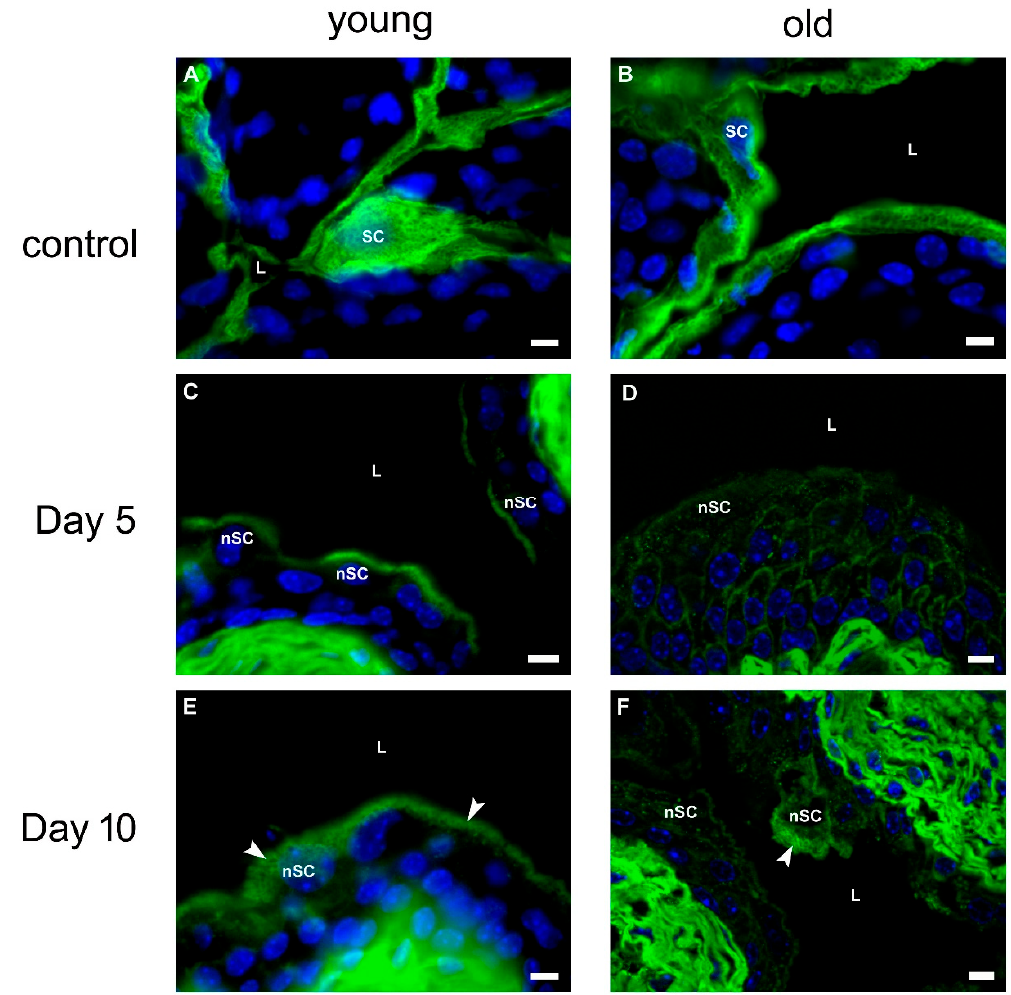
Figure 7. Representative micrographs of immunofluorescence detection of cytokeratin 20 (CK20) (green fluorescence) in the urothelium of young ( A , C , E ) and old ( B , D , F ) mice. In the urothelium of control young ( A ) and old ( B ) mice, the cytokeratin 20 (CK20) network is present in all superficial cells (SCs). On day 5 after chitosan treatment, the CK20 network appears in some new superficial cells (nSCs) of young mice ( C ), while in old mice, rare superficial cells express CK20 but are not organized into the network ( D ). On day 10 after chitosan treatment, all new superficial cells (nSCs) in young mice have a thin layer of the CK20 network in the apical cytoplasm (arrowheads) ( E ), while in old mice, only individual new superficial cells (nSCs) possess the CK20 network (arrowhead) ( F ). Cell nuclei are stained with 4 ′ ,6-diamidino-2-phenylindole (DAPI) (blue fluorescence). L-lumen of the urinary bladder. Scale bars: 10 µm (all images).